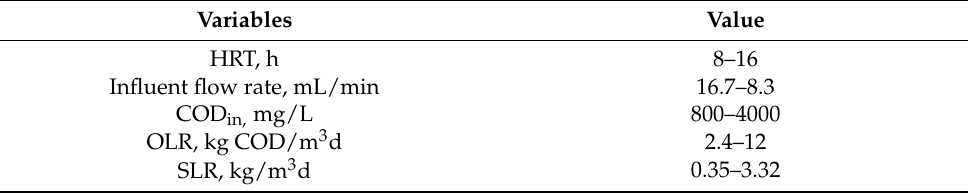
Figure 2. Photo of flexible fibre bundles. Table 3. A list of operating and process variables used in this study.